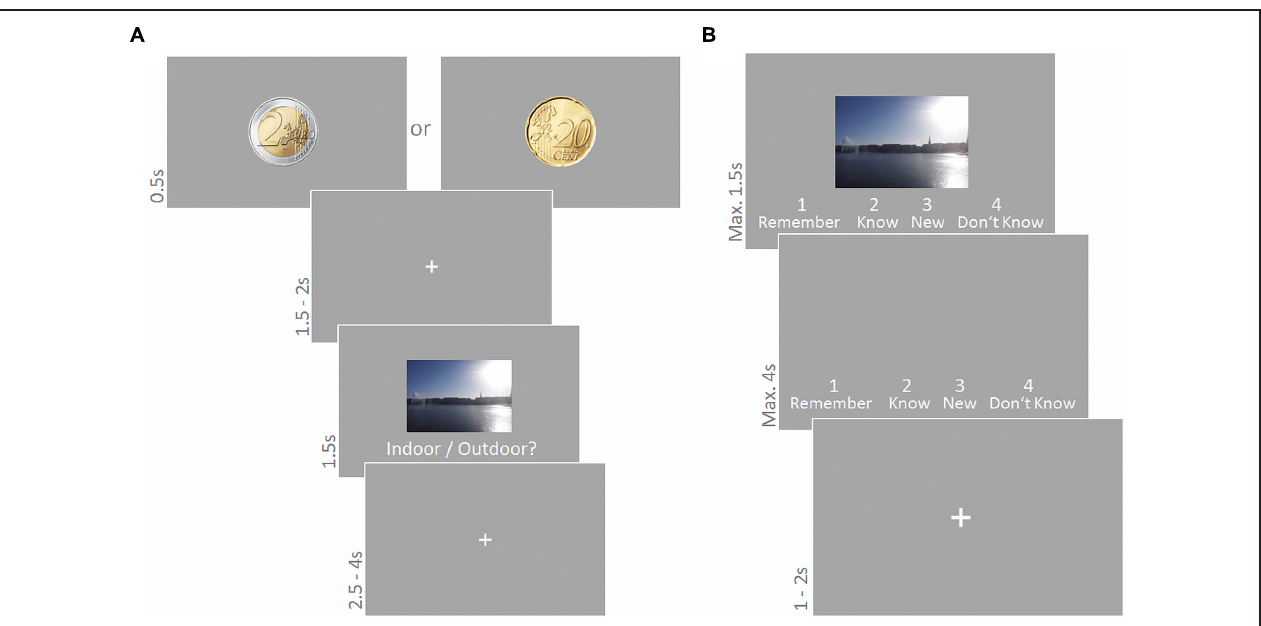
FIGURE 2 | Encoding phase (A) and recognition phase (B) of the reward based long-term memory task. Sound was presented during the encoding phase only. (A) A cue indicated whether participants would receive high or low reward for correctly recognizing the following picture in the subsequent recognition test. They had to indicate indoor/outdoor status of the scene image. (B) Participants judged old/new status in a modified remember/know